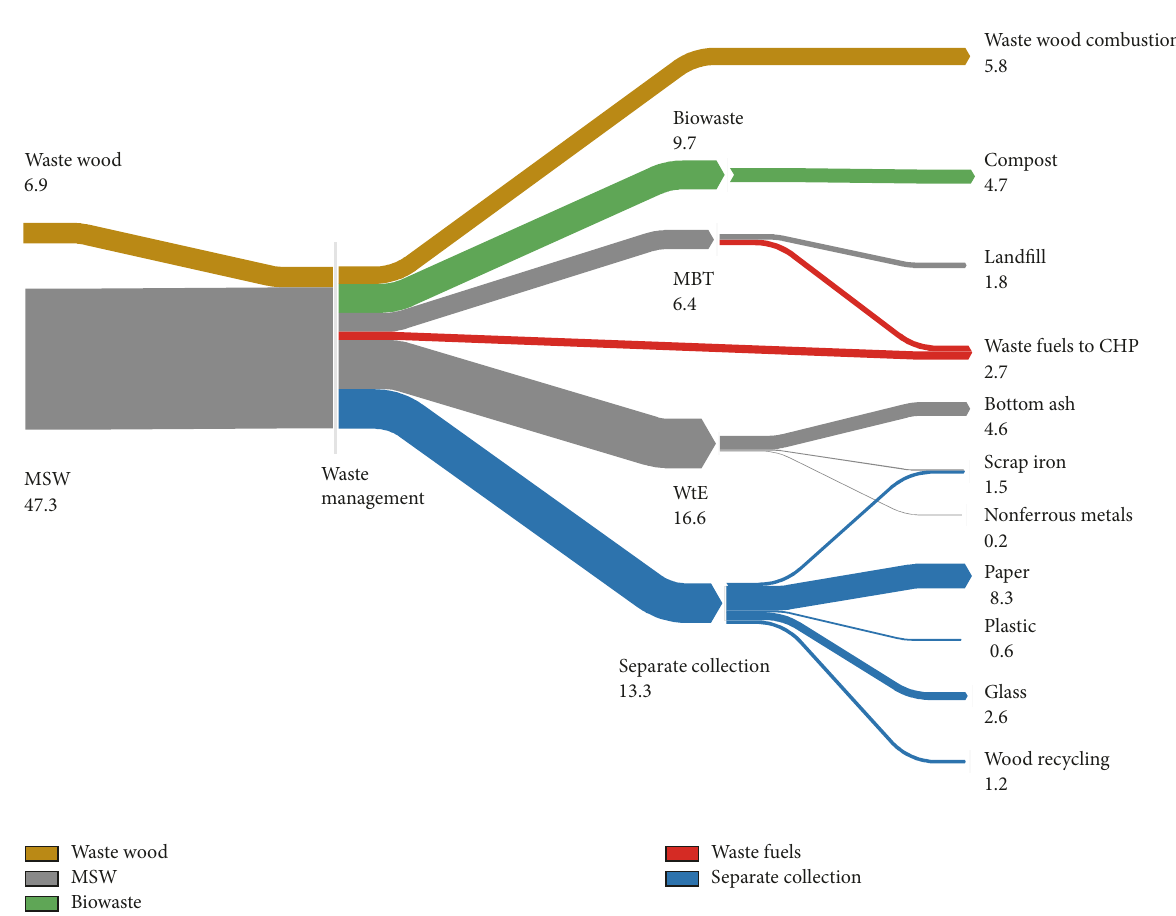
Figure 2: Flows of MSW in Germany (numerical data in 10 6 Mg from